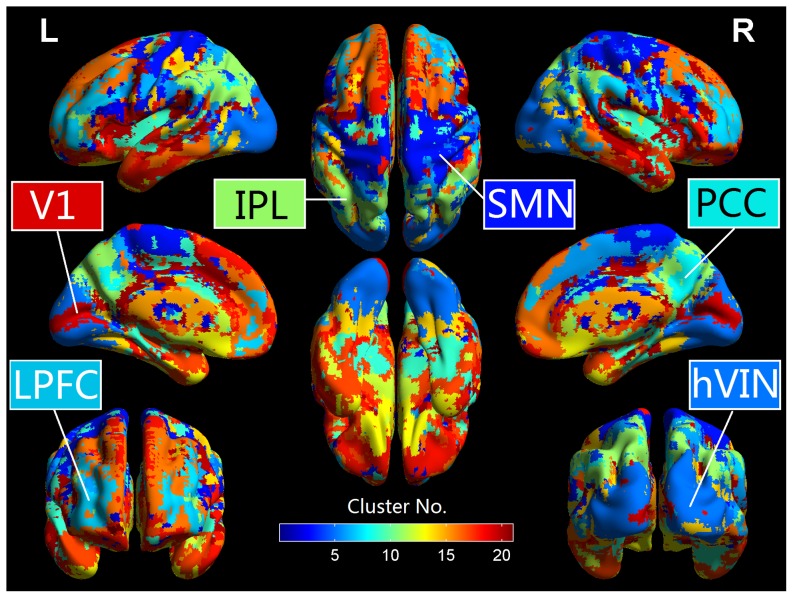
Result of k-means clustering.Voxels with similar frequency-specific ReHo characteristics were automatically classified into the same cluster. Different clusters are coded with different colors. Certain canonical cortical regions (networks) are identified and labeled include: posterior cingulate cortex (PCC)/precuneus, bilateral inferior parietal lobule (IPL), lateral prefrontal cortex (LPFC), primary visual area (V1), higher-order visual network (hVIN).